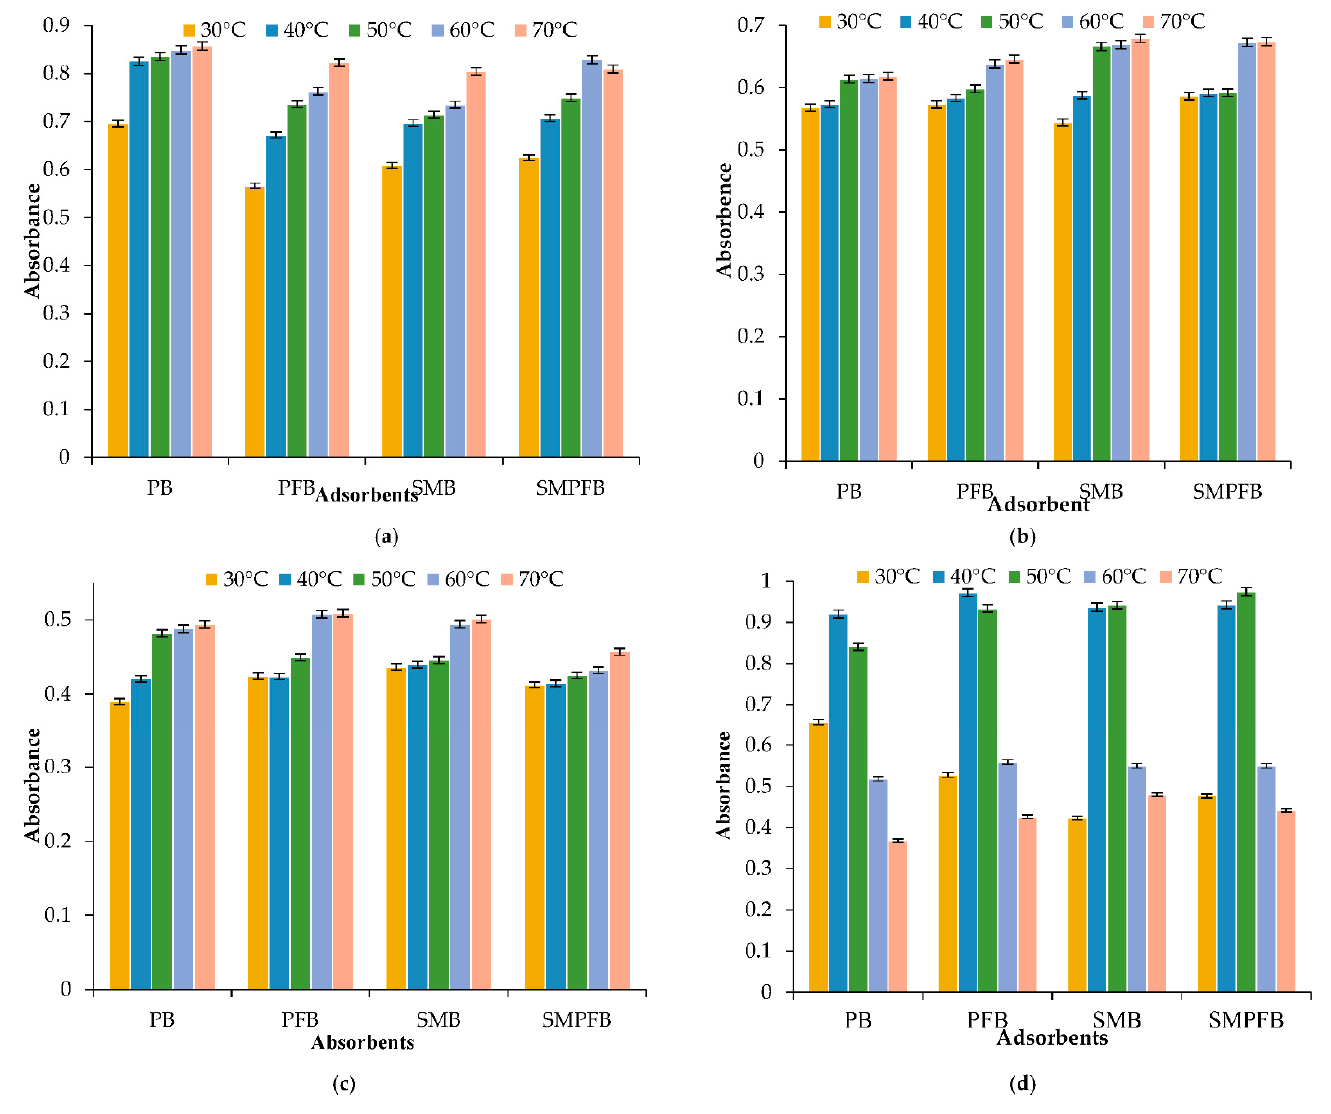
Figure 5. Removal of dyes at different temperatures. ( a ) Reactive Red, ( b ) Acid Red, ( c ) Reactive Green-5, ( d ) Direct Violet-51. Green-5, ( d ) Direct